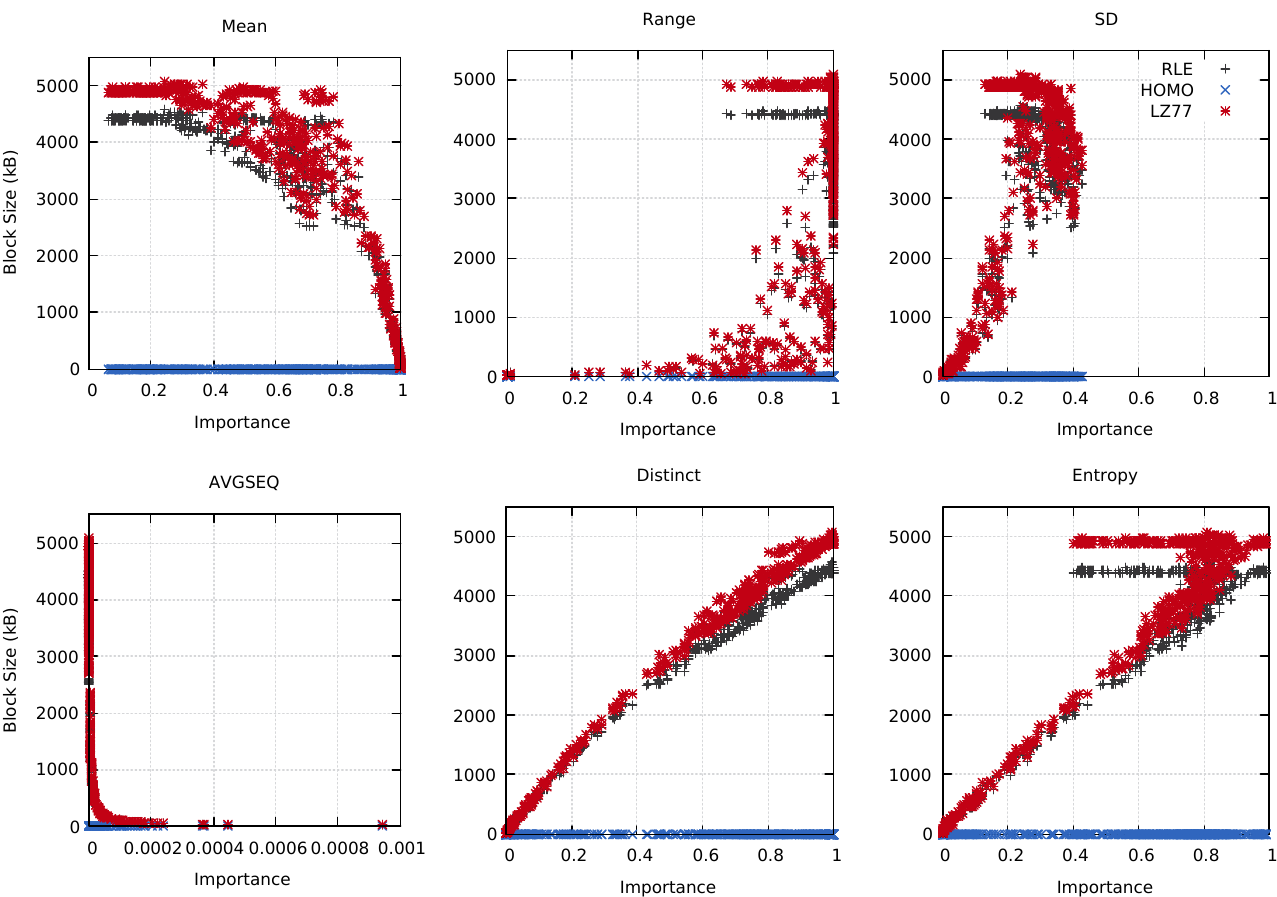
Figure 7. The compressed block sizes compared to the calculated importance for the MF data set using the Mean, Range, SD, AVGSEQ, Distinct, and Entropy probes. Tests were conducted on cluster A at time step